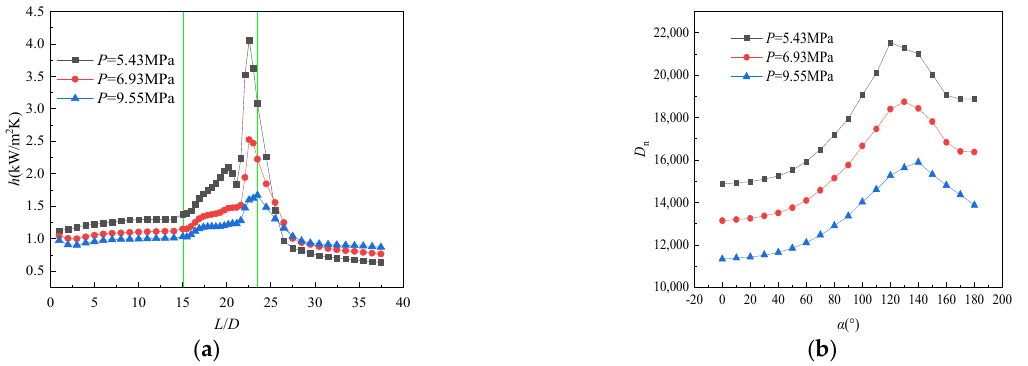
( b ) Figure 12. The changes in h with L / D and in Dn with α under different gravity conditions: ( a ) L/D , ( b ) α (°). According to Figure 12a, since gravity increases from − 12.8 m/s 2 to − 6.8 m/s 2 , the peak value of the surface heat transfer coefficient decreases from 2.5 W/m 2 ∙ K to 2.2 W/m 2 ∙ K, which is about 12%. This is because the buoyancy effect enhanced with the increase in gravity, that is, the buoyancy and flow acceleration caused by the change in bulk fluid density are considering. The secondary flow strength increases, which leads to the en ‐ hancement of heat transfer. The Dean number Dn under different gravity conditions has a similar magnitude in the horizontal direction, whereas its value differs greatly in other angle directions; this distribution pattern observed in Figure 12b. In summary, the influ ‐ ence of various parameters on the heat transfer performance is in the order of pressure p , mass flux G , gravity g , and heat flux q , from large to small. 3.6. Flow Heat Transfer Comparison between Different Tubes It can be seen from Figure 13 that before the fluid enters the bend, the Nu curve in the two tube types is basically coincident, indicating that there is no difference in heat